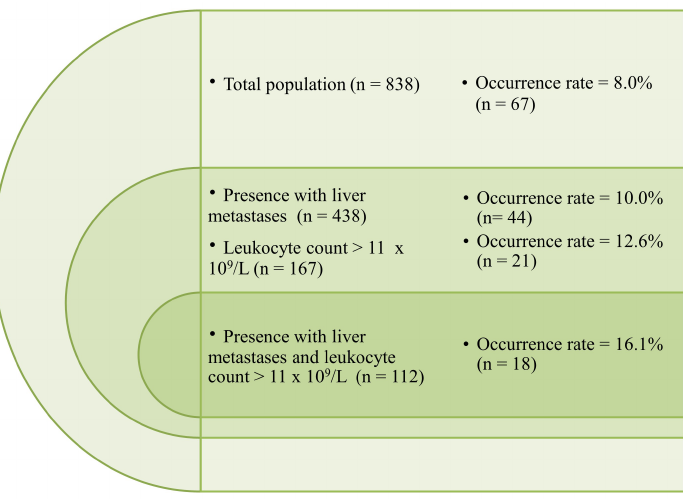
Figure 2. Cumulative rate of VTE among 67 VTE patients.